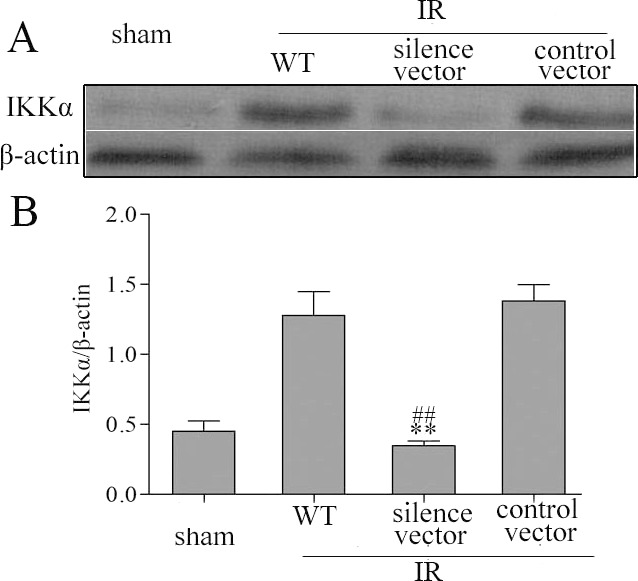
IKKα expression was effectively suppressed by IKKα-shRNA in vivo and in vitro. (A) C57BL/6 mice underwent: a sham-treated operation; IR produced by unilateral renal pedicle clamping for 45 min followed by reperfusion (WT); or IR conducted 2 weeks after renal parenchyma injection of GV118-GFP-shRNA-IKKα lentiviral vectors (silence vector) or GV118-GFP-lentiviral vector (control vector). The kidneys were harvested on day 3. (B) NRK52E cells were cultured with lymphotoxin-LIGHT to activate the IKKα pathway (lane 1), or transfected with control vectors (lane 2) or GV118-GFP-shRNA-IKKα lentiviral vectors (lane 3). IKKα protein levels in the kidneys were detected by western blotting after normalization to β-actin levels. Data are expressed as mean±s.d. (n=6 mice), **P<0.01 versus wild type, ##P<0.01 versus control vector.